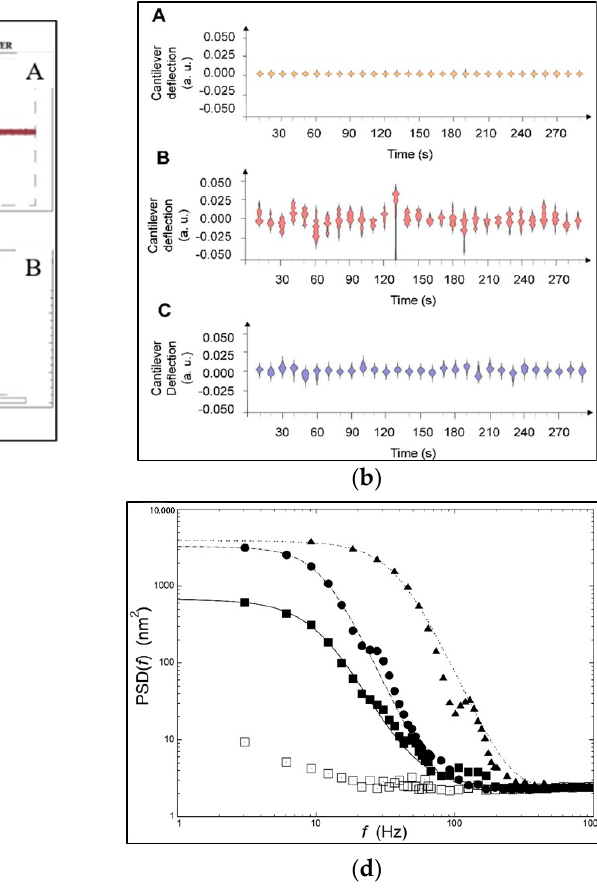
Figure 7. The AFM nanomotion technique results display methods: ( a ) the variance of the cantilever deflection result, (A) the cantilever deflections as a function of ATP concentration, (B) corresponding variance values, “reprinted with permission from Ref. [153]. 2014, Plos One”; ( b ) violin plot for 10 s chunk of the cantilever deflection result, (A) nanomotion cantilever violin plot without samples, (B) with virulent sample and (C) with avirulent sample, “reprinted with permission from Ref. [158]. 2021, MDPI”; ( c ) damping value (B value) of the cantilever deflection result, A) cantilever oscillation deflection amplitude versus time, (B) heatmap of the damping constants, C) damping constants B for different agents versus agents' concentration, “reprinted with permission from Ref. [127]. 2017, Springer Nature”; ( d ) the power spectral density (PSD) of the cantilever deflection result (black squares: 2.0 μ M ATP concentration, black circles: 0.2 mM, black triangles: 2.0 mM and white squares: baseline), “reprinted with permission from Ref. [153]. 2014, Plos One”.